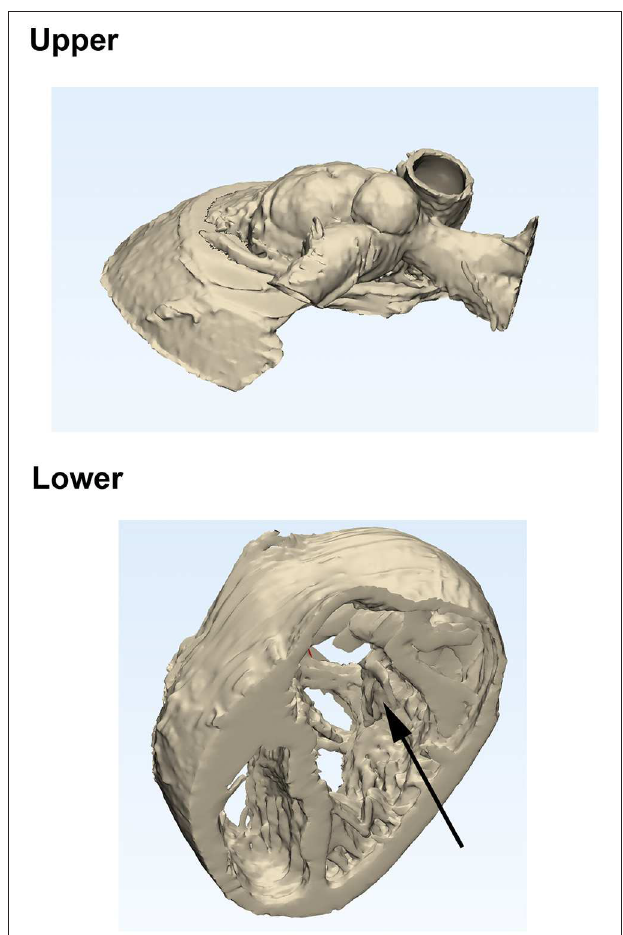
FIGURE 3 | Model produced from later CT scan shortly before surgery. Screenshot from Materialize 3-Matic showing how the model would be cut ( Upper and Lower portions), and demonstrating the tricuspid valve